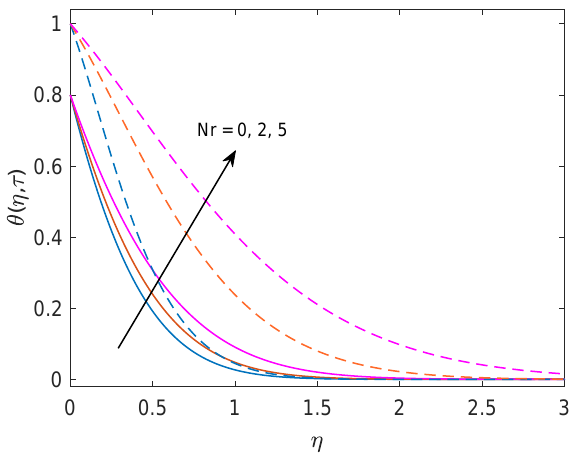
Figure 13. Effect of different values of